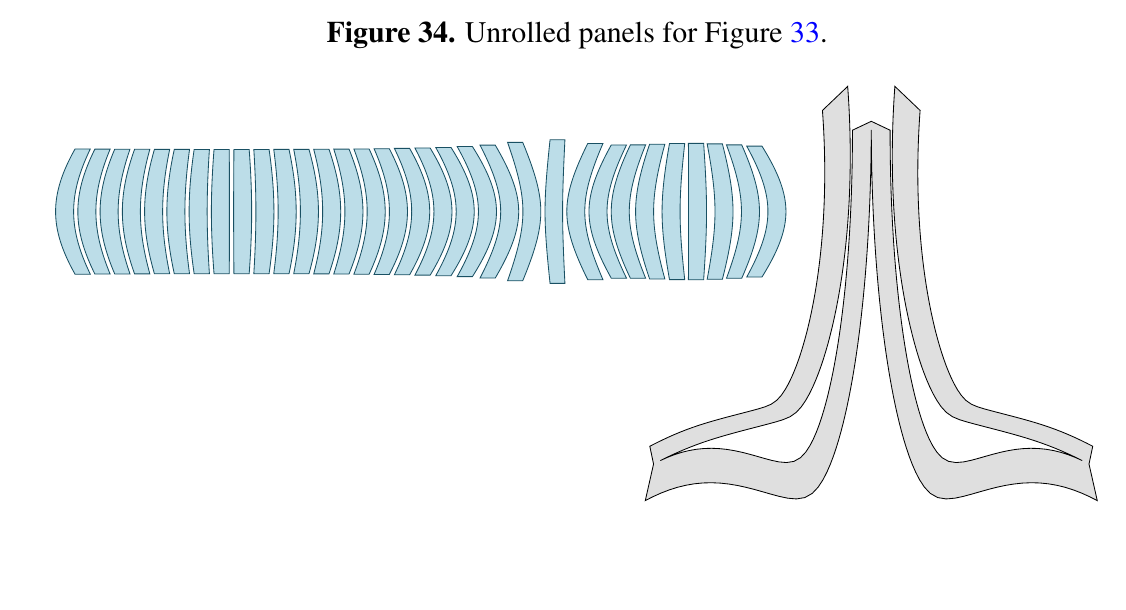
Figure 34. Unrolled panels for Figure